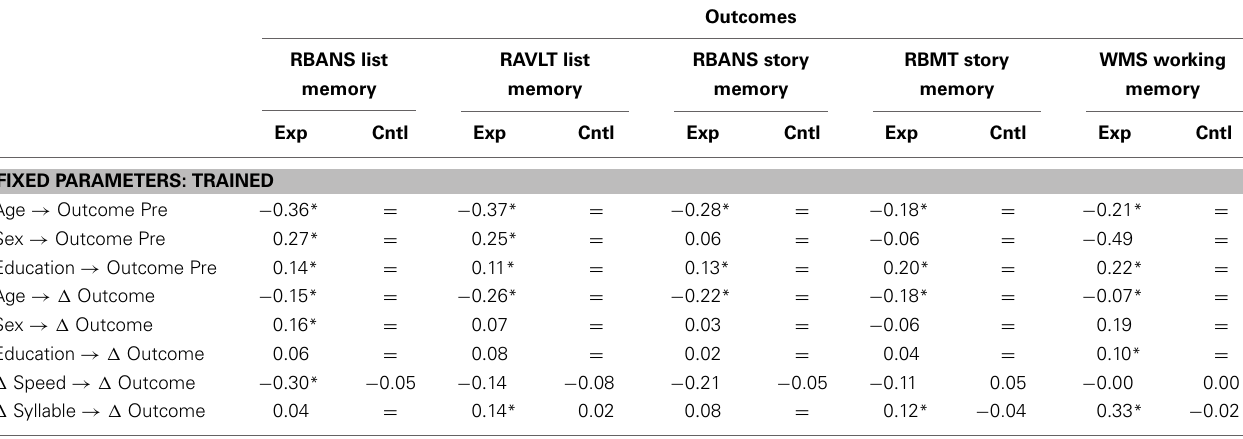
Table 9 | Standardized parameters for analyses with